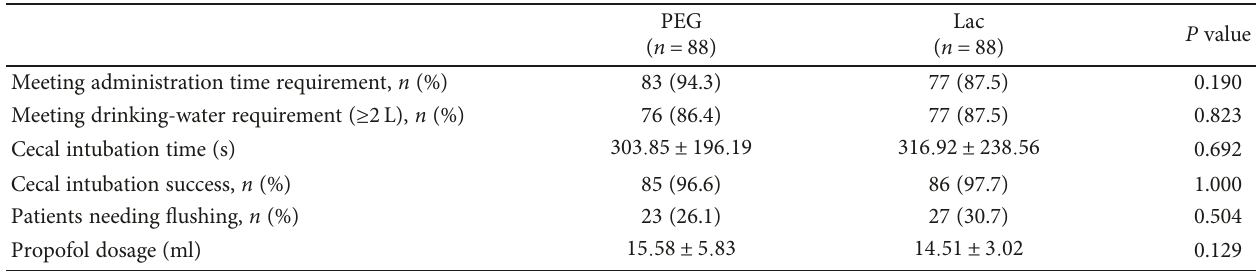
Table 3: Bowel preparation characteristics and colonoscopy results.